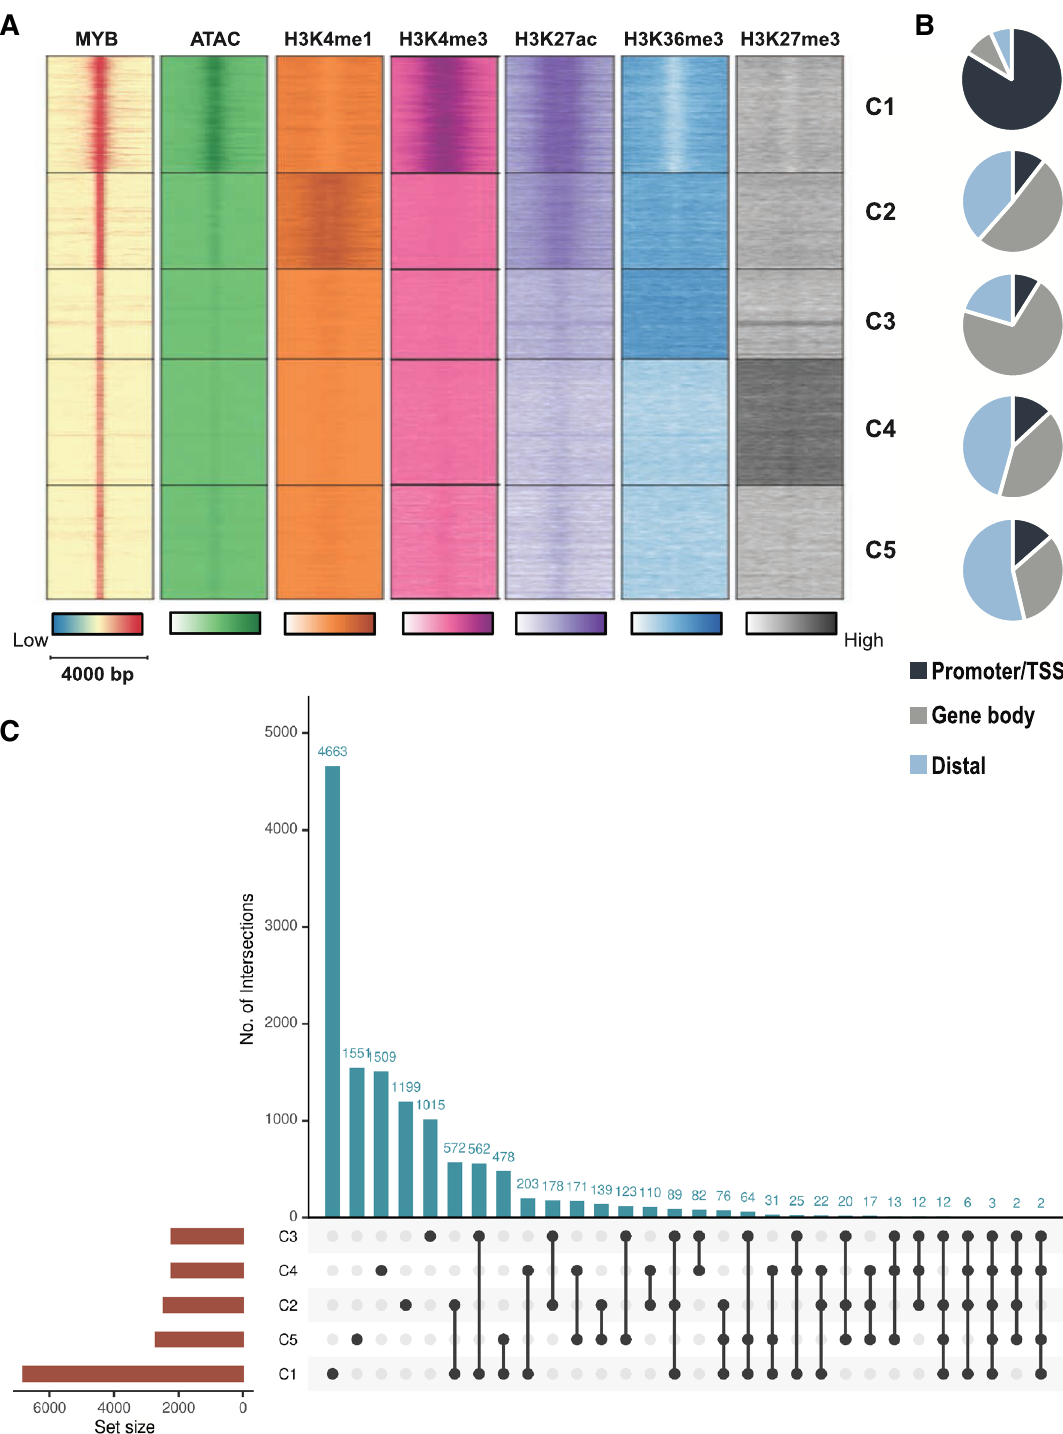
Figure 3. Epigenome-wide clustering of MYB. ( A ) Heatmap displaying the current MYB ChIP-seq signal, public ChIP-seq signals for H3K4me1 (GSM733692), H3K4me3 (GSM733680), H3K27ac (GSM733656), H3K36me3 (GSM733714), and H3K27me3 (GSM733658) ChIP-seq, and ATAC-seq signal from our previous data (GEO accession: GSE92871) within a 4 kb window around the summit of MYB bound regions. We identified five clusters as indicated on the heatmaps, generated by ChAsE 1.1.2 46 (termed C1-C5 in the figure). ( B ) Distribution of MYB binding sites between TSS/promoter, gene body or distal regions in each cluster C1-C5. ( C ) An upset plot showing overlaps of the number of genes associated with each C-group. The upset plot was generated using the Intervene upset module v0.6.4 78